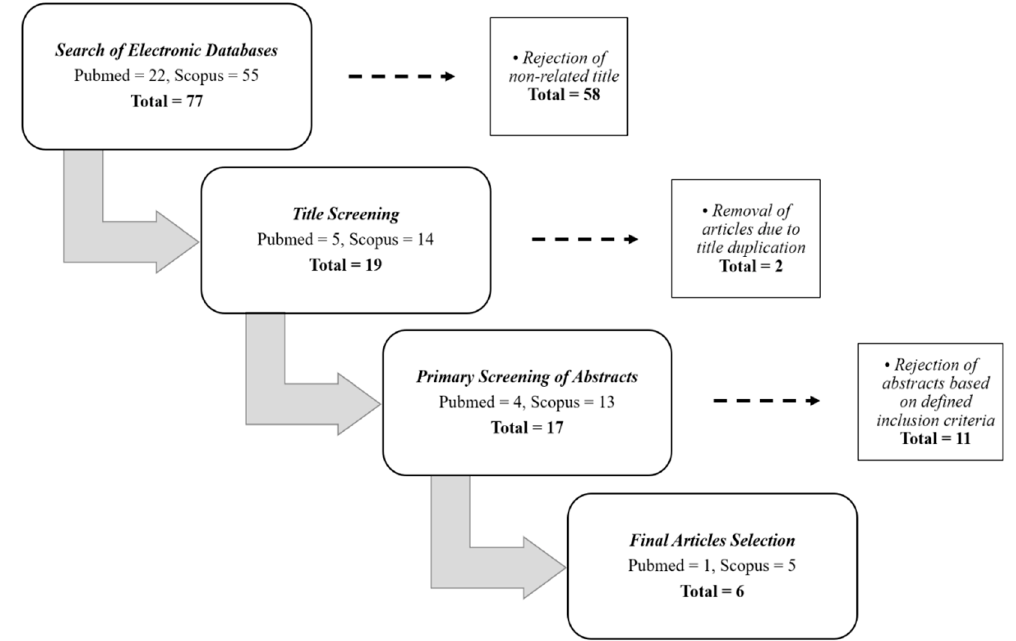
Figure 1. The process flow of the final articles selection from both Pubmed and Scopus databases.